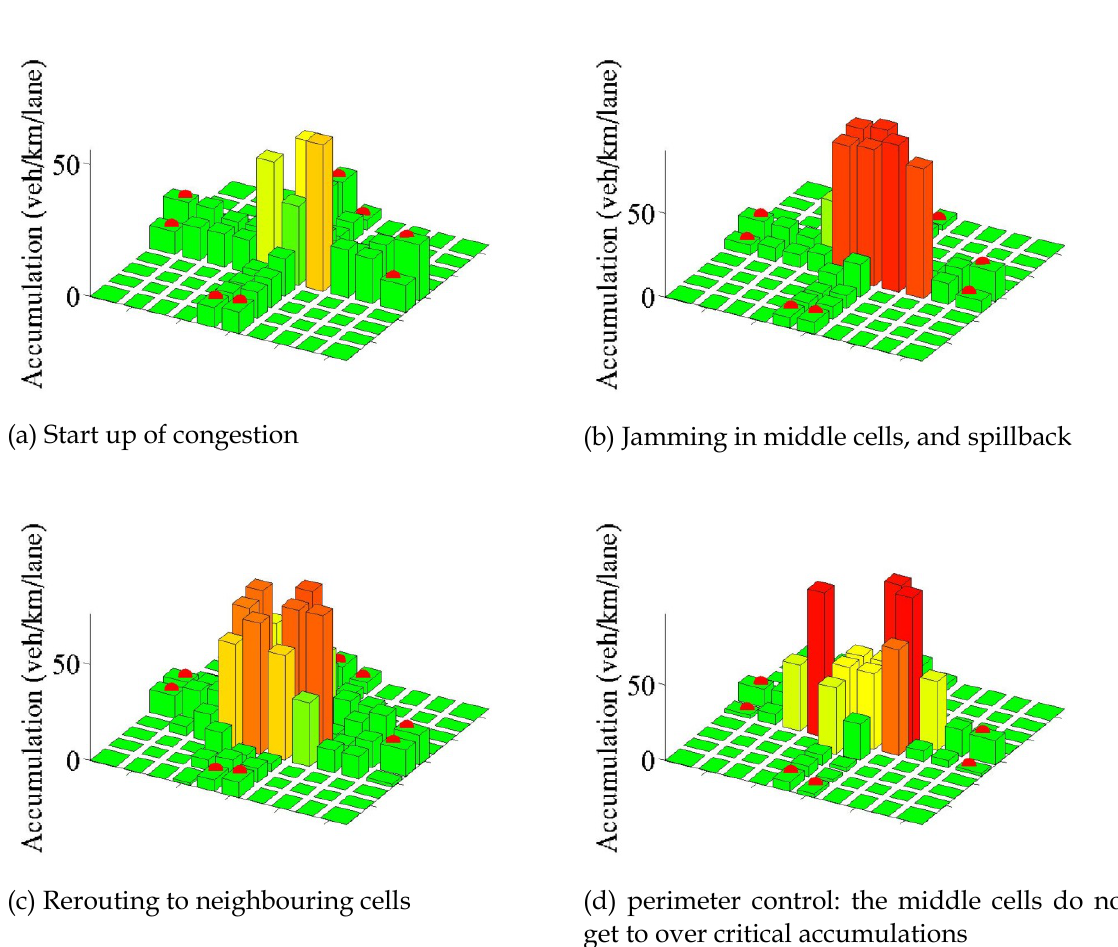
Figure 5. Snap shots of the traffic operations – colour indicates speed, and bar height